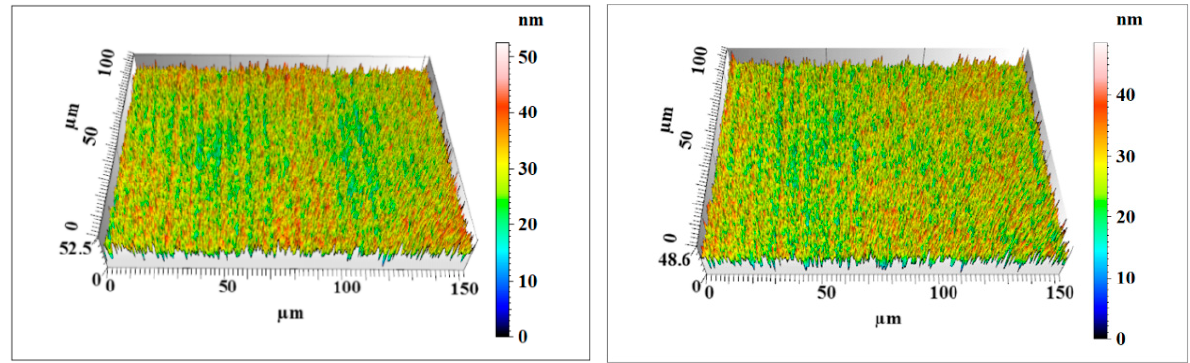
Figure 16. The UV induced nanoparticle colloid jet machining Si workpiece surface morphology.